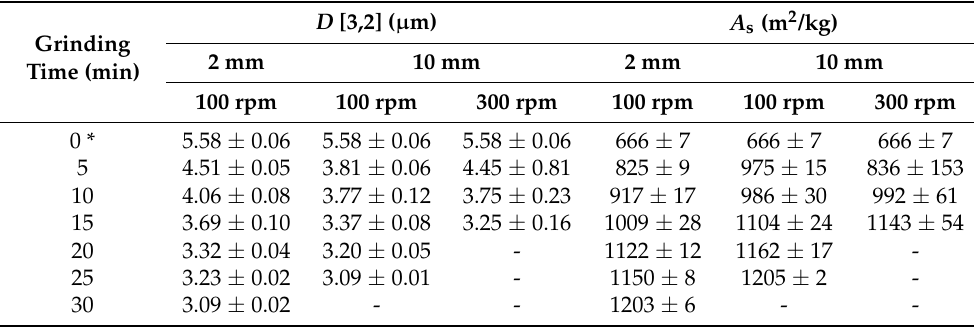
Table 2. Sauter diameter ( D ) [3,2] and specific surface area ( A s ) obtained by laser diffraction for the MLX reference samples milled under different conditions with two sizes of grinding balls (2 and 10 mm) and two mill rotation speeds (100 and 300 rpm).